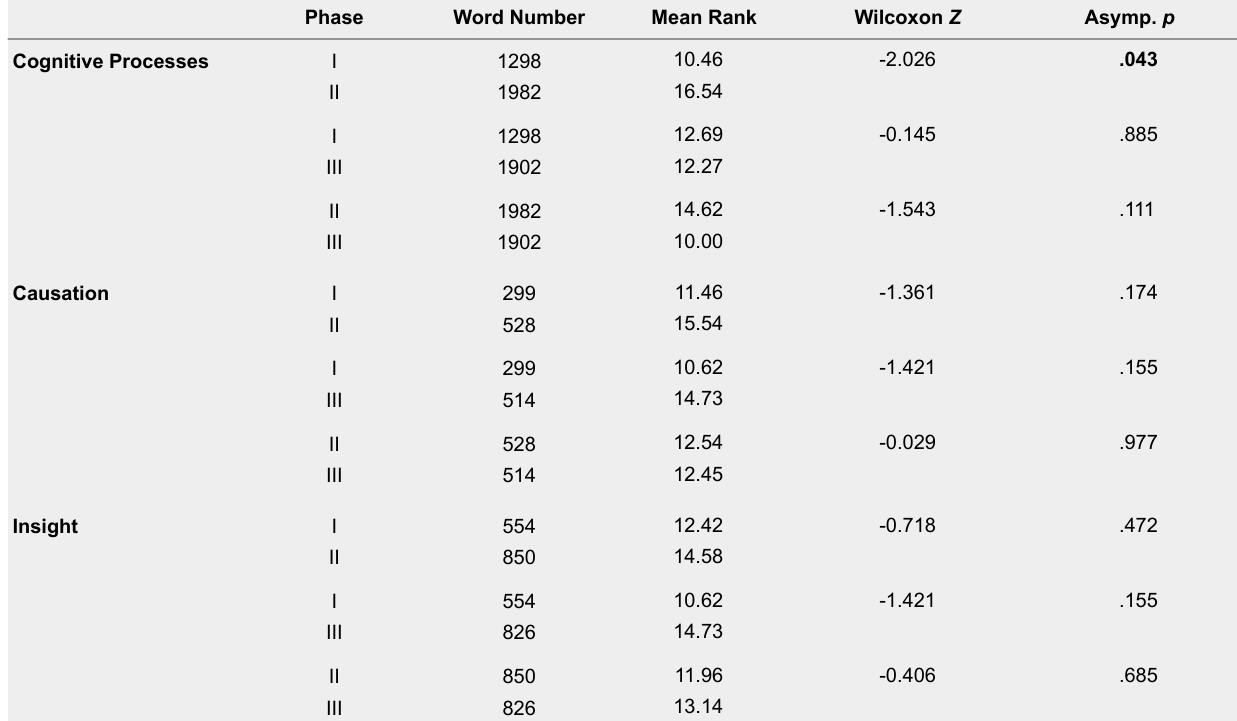
Wilcoxon Test for the Cognitive Dimension of Mentalization